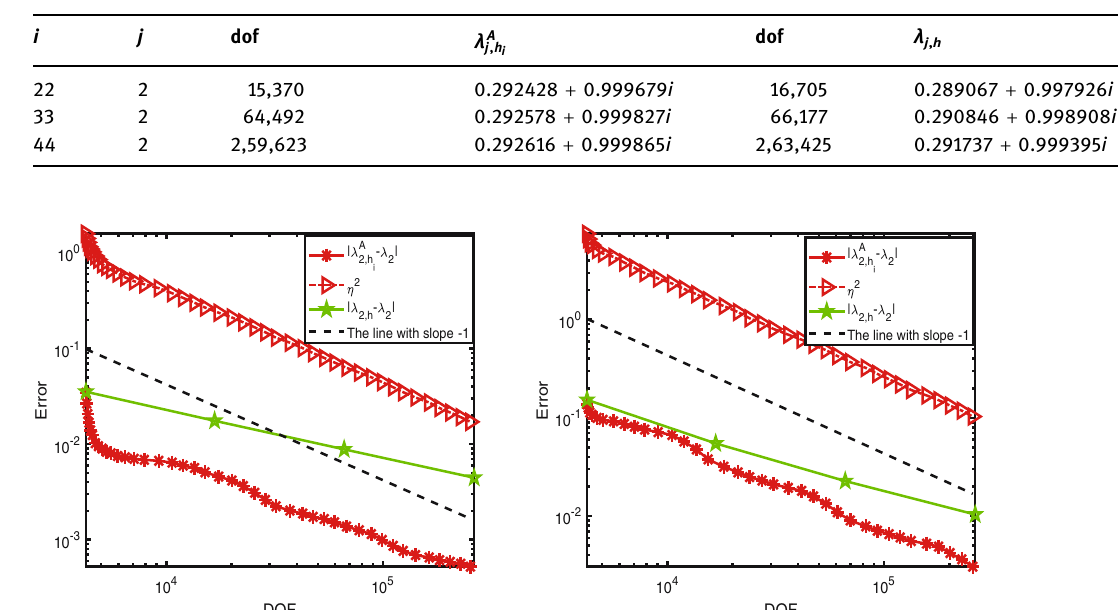
Figure 6: Error comparison of the eigenvalues for ( 2.1 ) – ( 2.2 ) on the square with a slit ( the left: k = 2, n ( x ) = 4 + 2 i , the right: k = 4, n ( x ) = 4 + i ) .